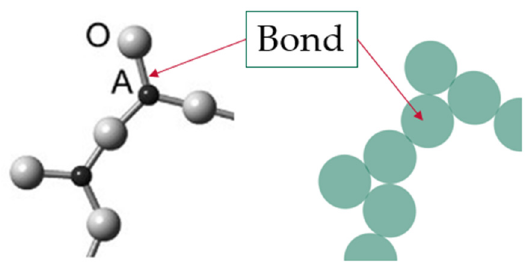
Figure 1. Example of a congruent bond lattice (CBL) model for an A 2 O 3 glass. The structure of glass composed of A 2+ cations connected via bridging O 2 − anions is replaced by the CBL shown in green color, with bonds that are assumed to take a spherical form.